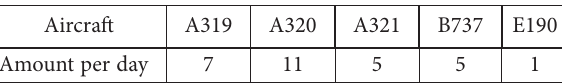
Table 9. Daily operations per aircraft (source: Aerocivil, 2021) Aircraft A319 A320 A321 B737 E190 Amount per day